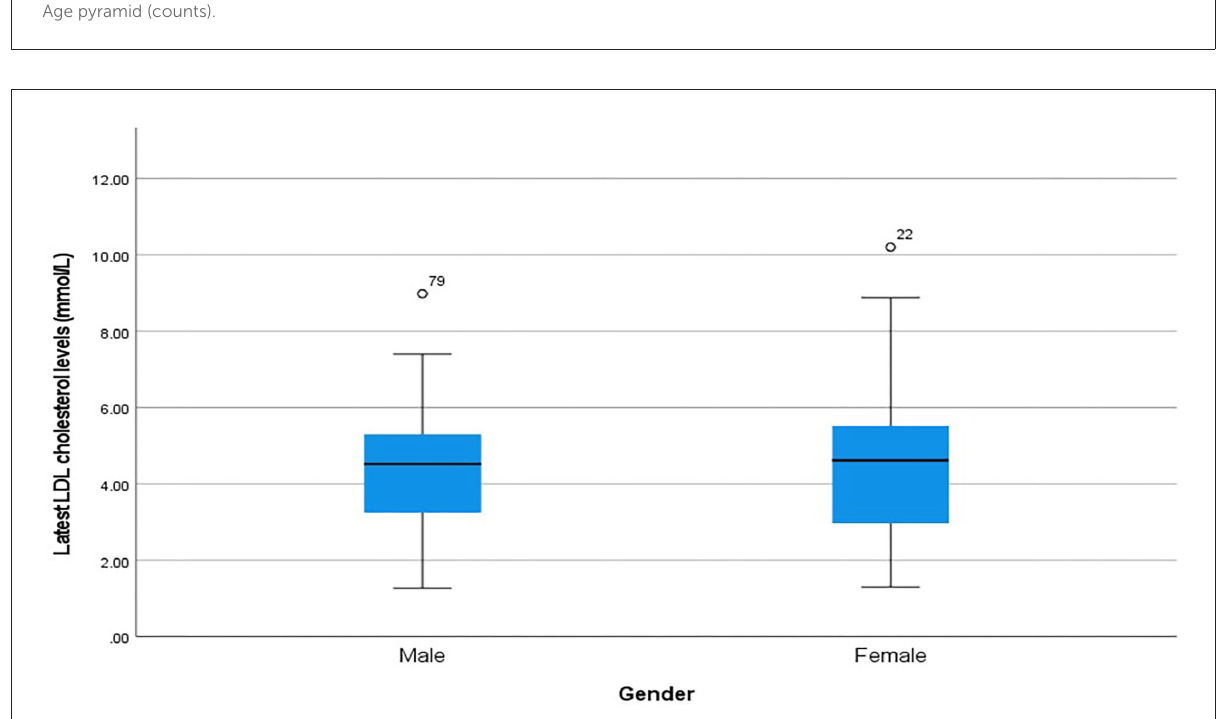
FIGURE2 Comparison of the most recent LDLc mean for males and females.